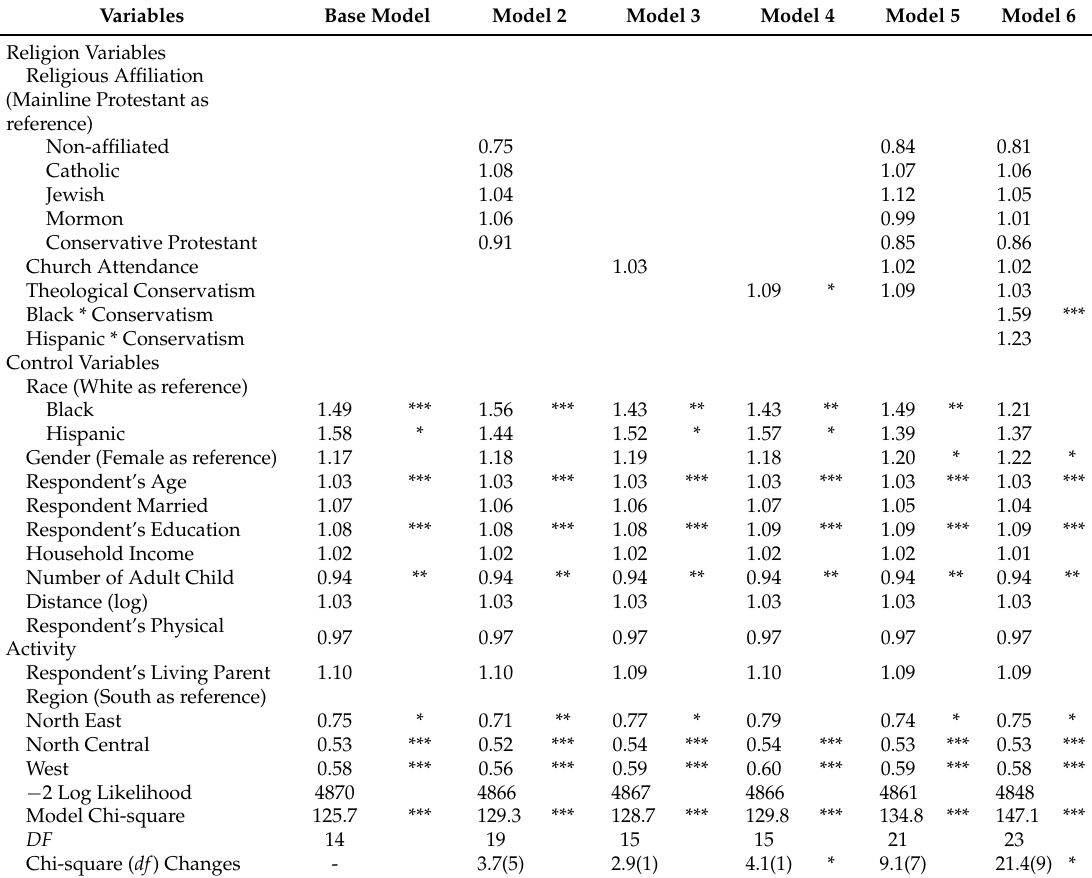
Financial Aid ( n =